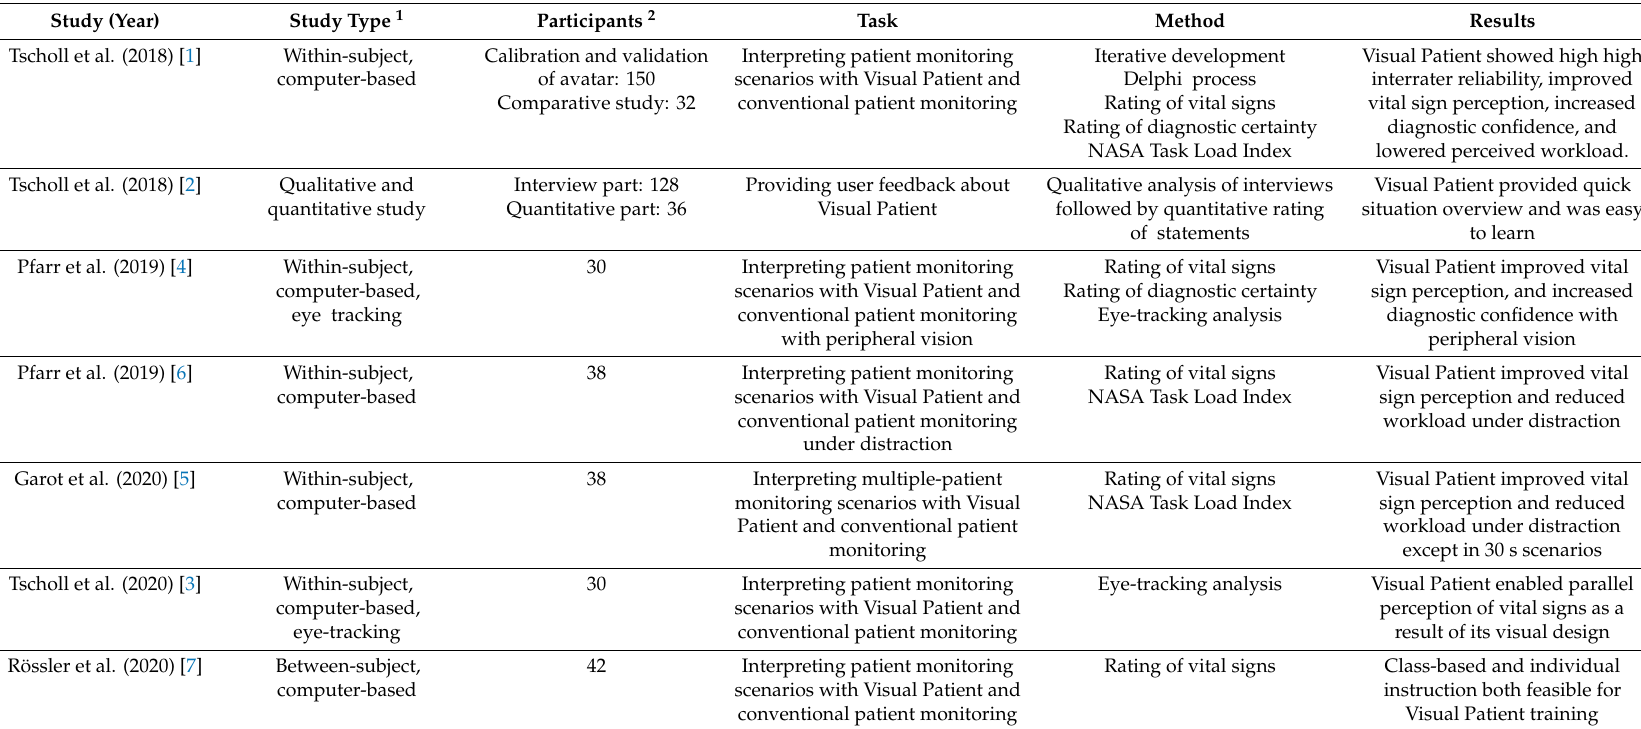
Table 2. Summary of the reviewed